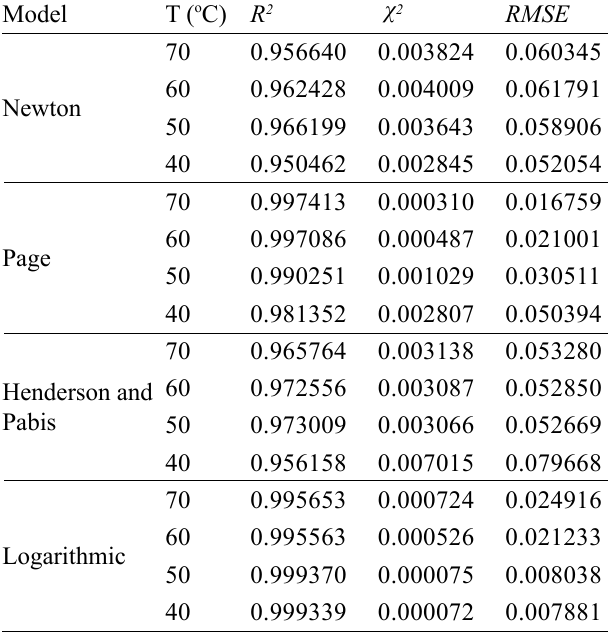
Table 5. Statistical results of mathematical models fitting for moisture ratio at different drying air temperatures